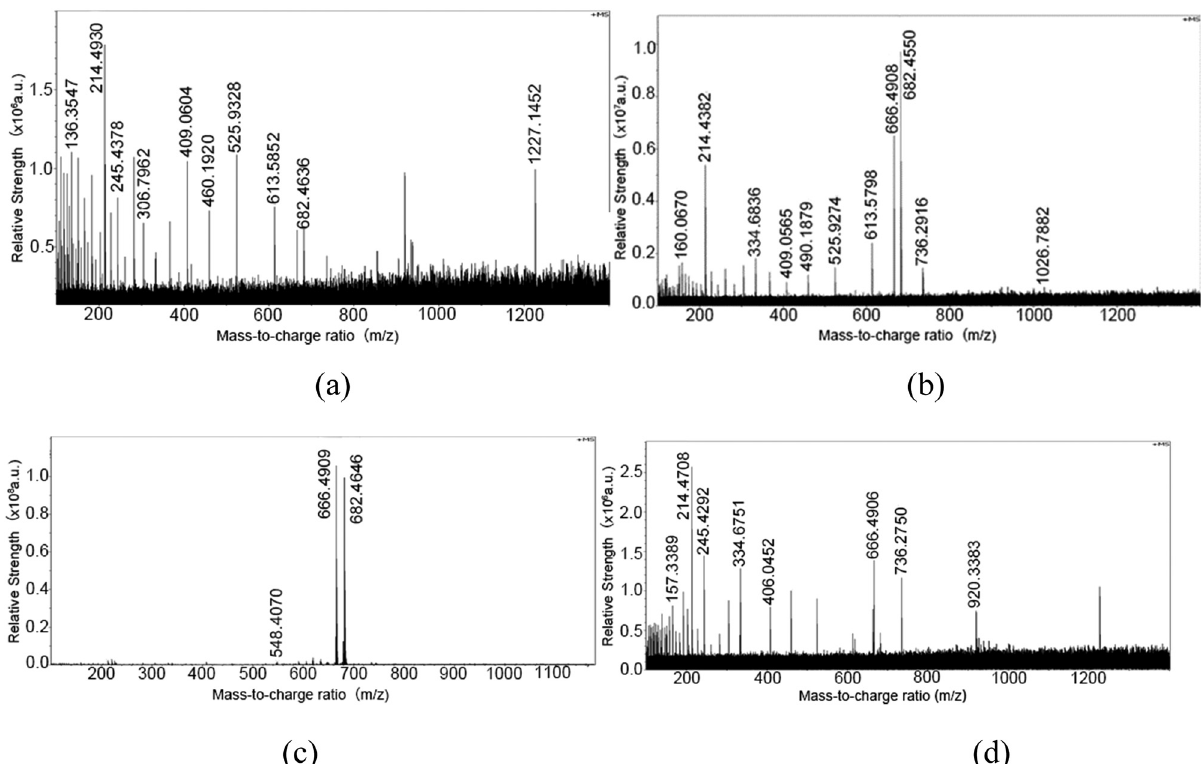
Figure 3: The mass spectrum of GC under the conditions of ( a ) 0.01 mg, ( b ) 0.1 mg, ( c ) 1 mg, and ( d ) 10 mg of TiO 2